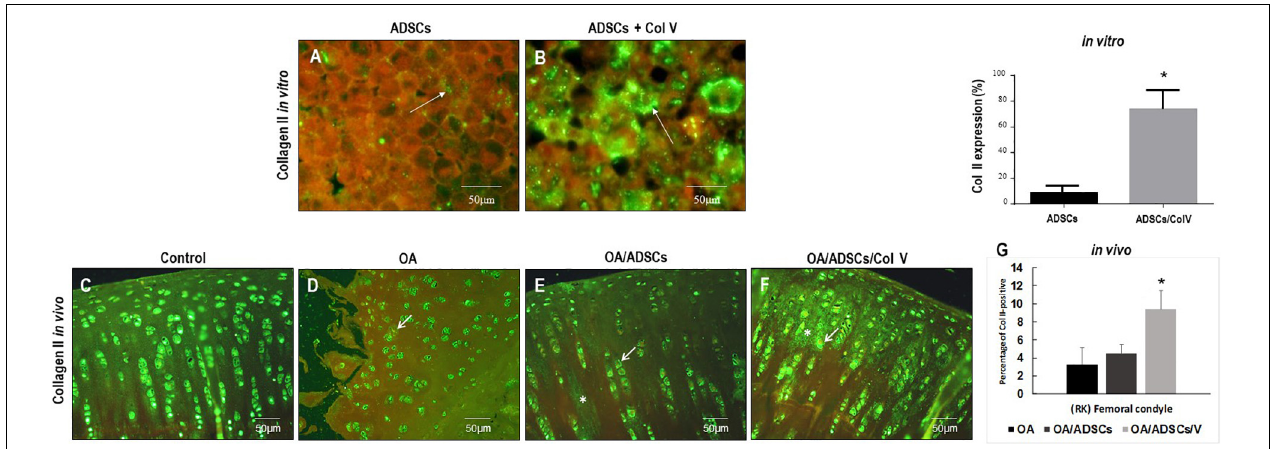
FIGURE 3 | Representative images of the strong green birefringence by immunofluorescence of Col II after 3 days with Col V (50 mg/ml) during the process of Col V/ADSC treatment in vitro (A,B) and in vivo (C–F) . The (G) shows the representative graphics of the amount of Col II expression in vitro and in vivo evaluated by Image-Pro Plus 6.1 software. * P < 0 .